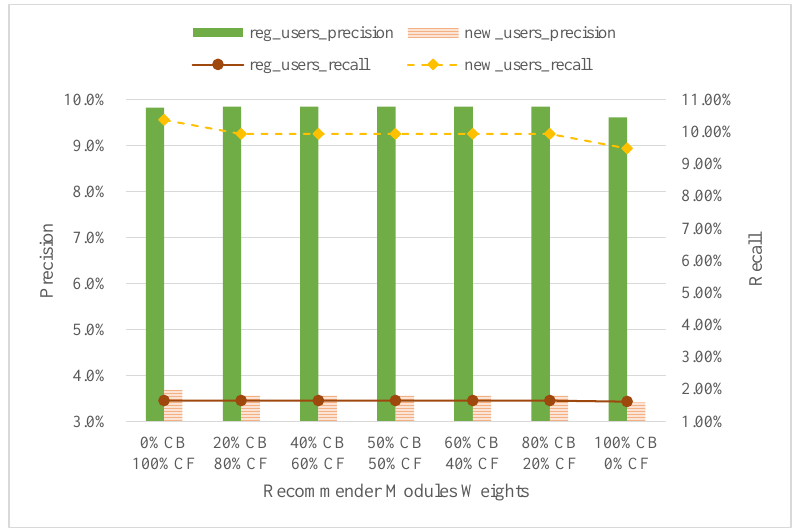
Figure 7. Precision and recall comparison of regular users and new users, using different content- based and collaborative filtering modules